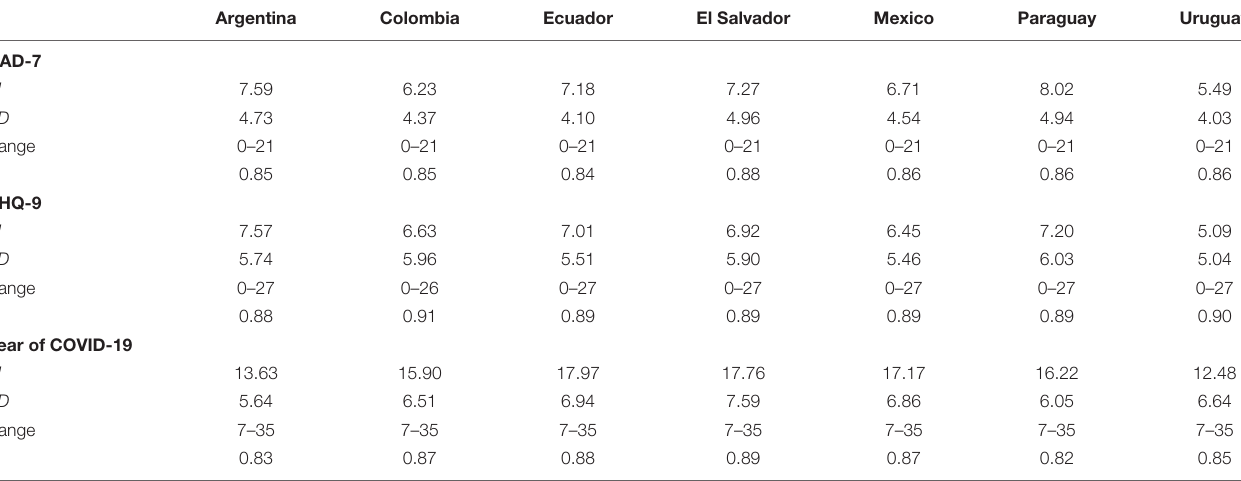
TABLE 2 | Descriptive statistics of the GAD-7, PHQ-9, and FCV-19S.